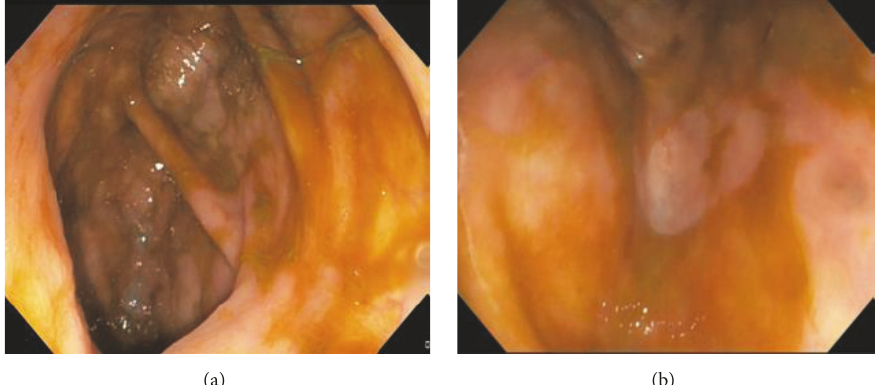
Figure 3: Complete resolution of cecal GIP after 8 months of adalimumab therapy.